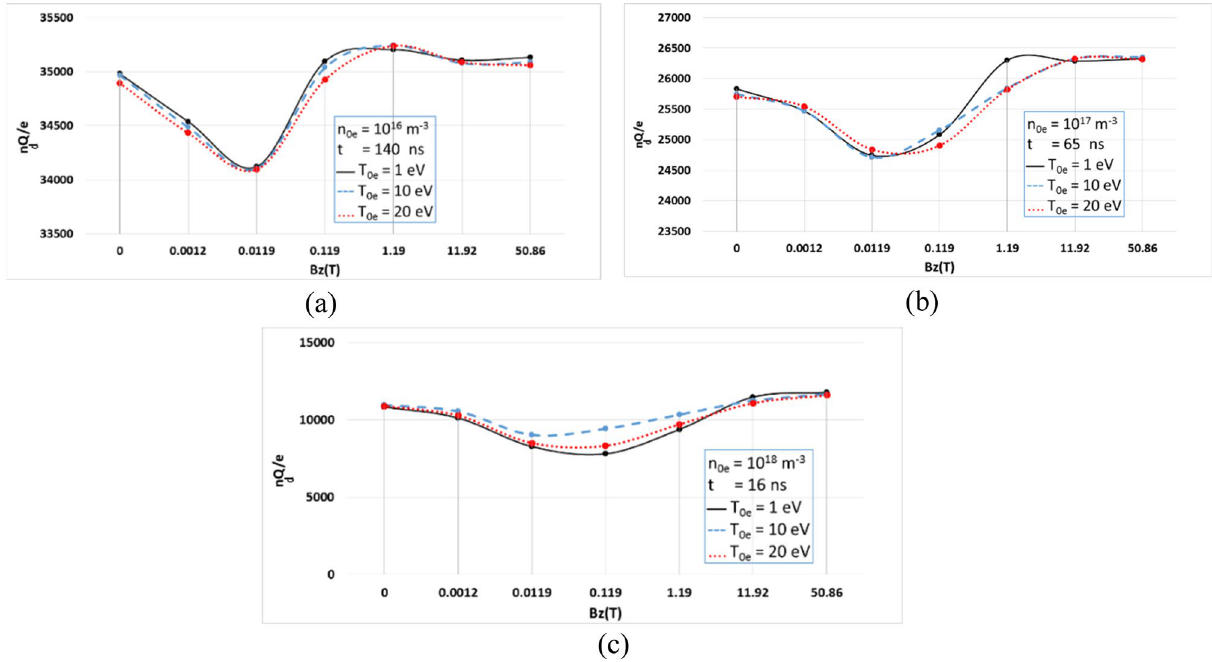
Figure 4. Dust particle charges at saturation time, where exposed to different magnetic fields; B z = 0, 0.0012, 0.0119, 0.119, 1.192, 11.92, 50.86 T, different initial electron temperatures; T 0e = 1, 10, 20 eV, and different